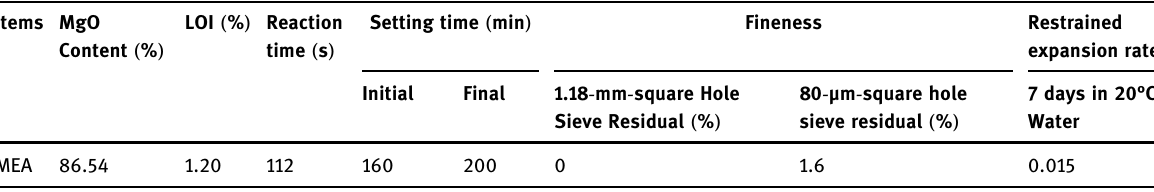
Table 3: Properties of MEA and mortar with MEA Items MgO